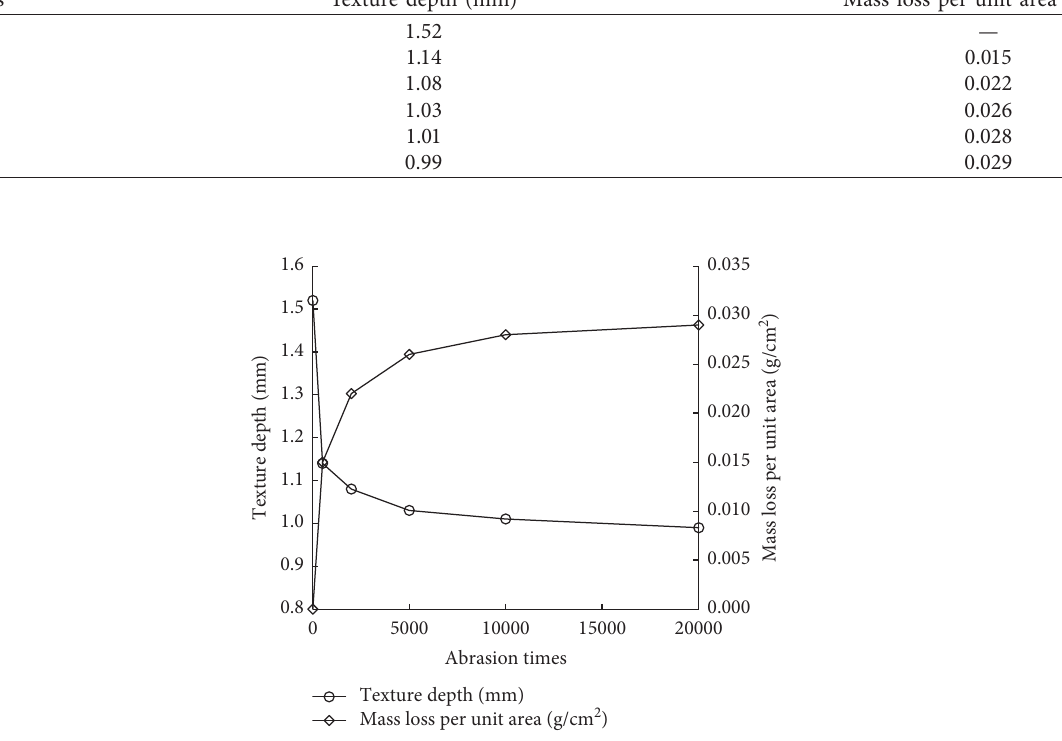
Figure 16: The texture depth and mass loss per unit area of the color nonslip layer under different wear